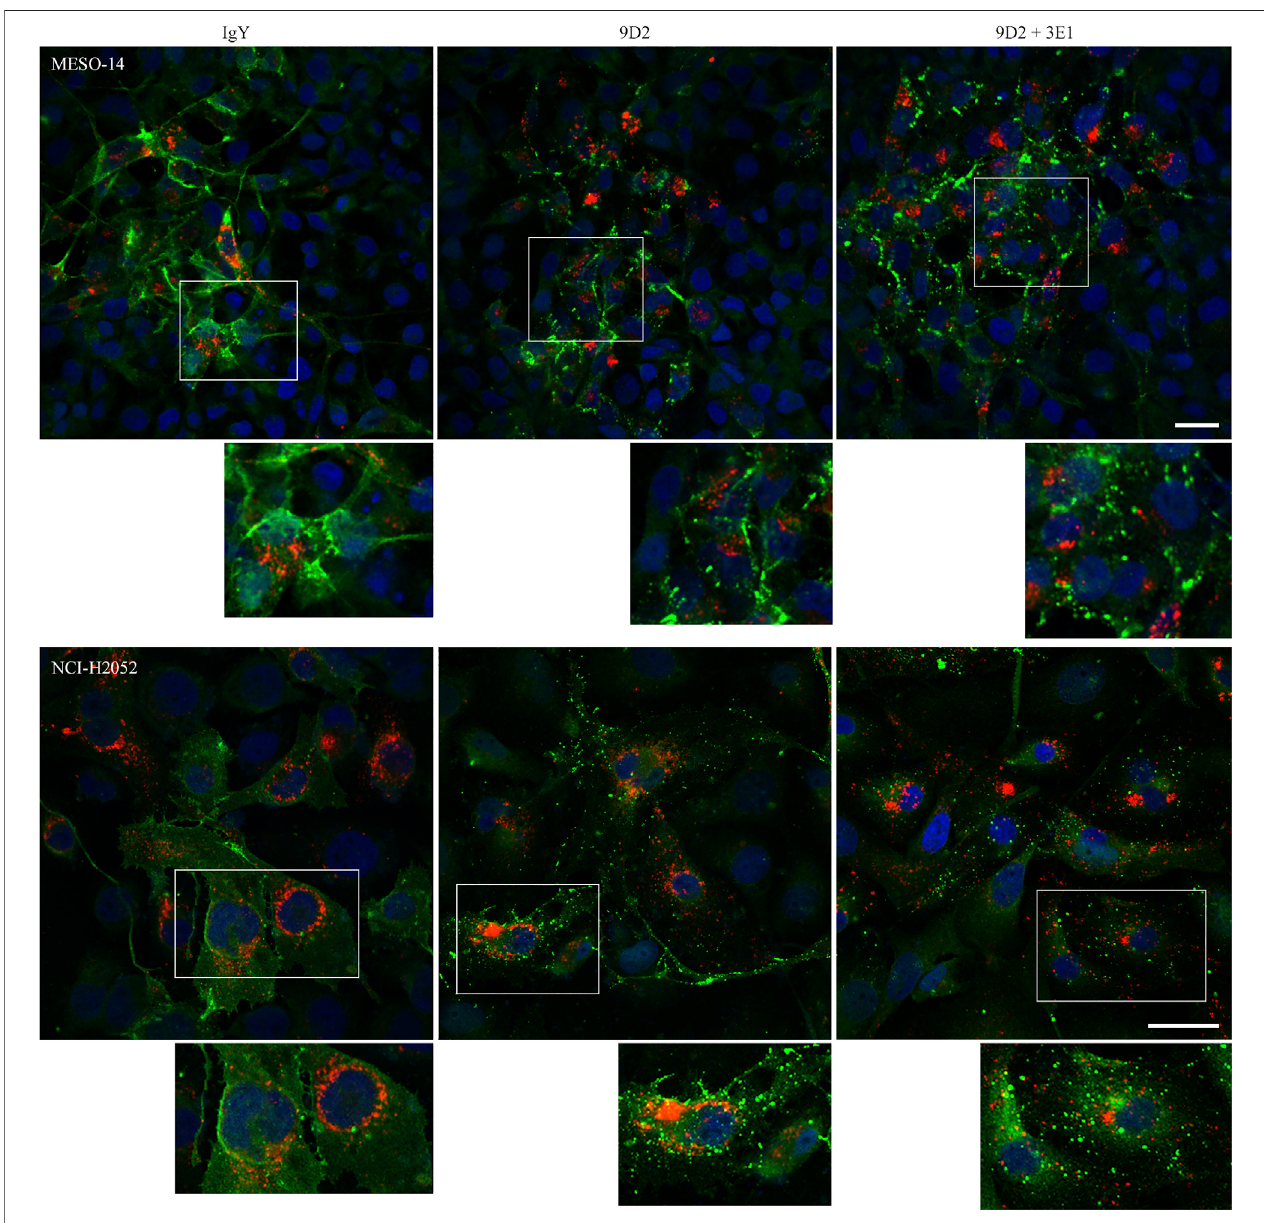
FIGURE 2 | Immuno fl uorescence of CADM1 in MESO-14 and NCI-H2052 cells cultured on a MeT-5A cell monolayer in the presence of 9D2 and 3E1. MESO-14 and NCI-H2052 cell sheets were labeled with DiI (red) and were cocultured on a MeT-5A cell monolayer in the presence of control IgY (1.0 μ g/ml; left), 9D2 (1.0 μ g/ml; middle),or9D2and3E1(1.0 μ g/mleach;right).After2 days,thecocultureswereimmunostainedwiththeanti-CADM1antibody(green).Nucleiwerecounterstainedwith DAPI (blue). Images were captured by a confocal microscope; representatives are shown. Bar = 50 μ m. In each photomicrograph, a boxed area is enlarged at the bottom for observation at single-cell